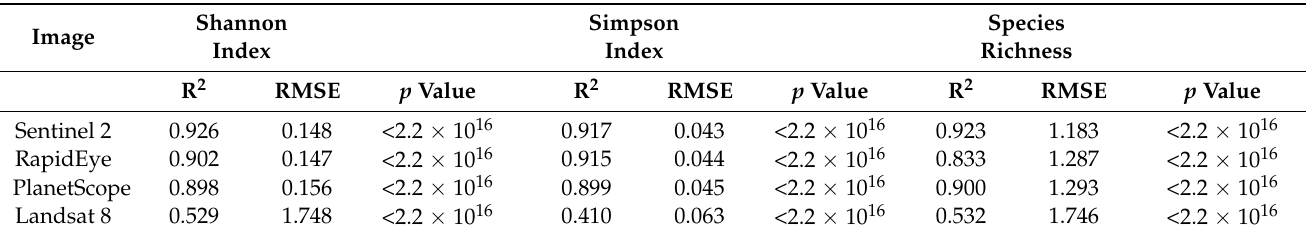
Table 3. RF sensor model accuracies for the Sentinel 2, RapidEye, PlanetScope and the Landsat 8 for Shannon Index, Simpson Index and the Species Richness.